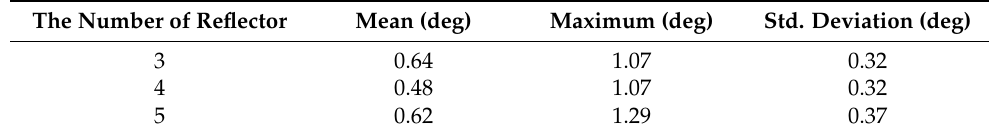
Table 3. Orientation error.